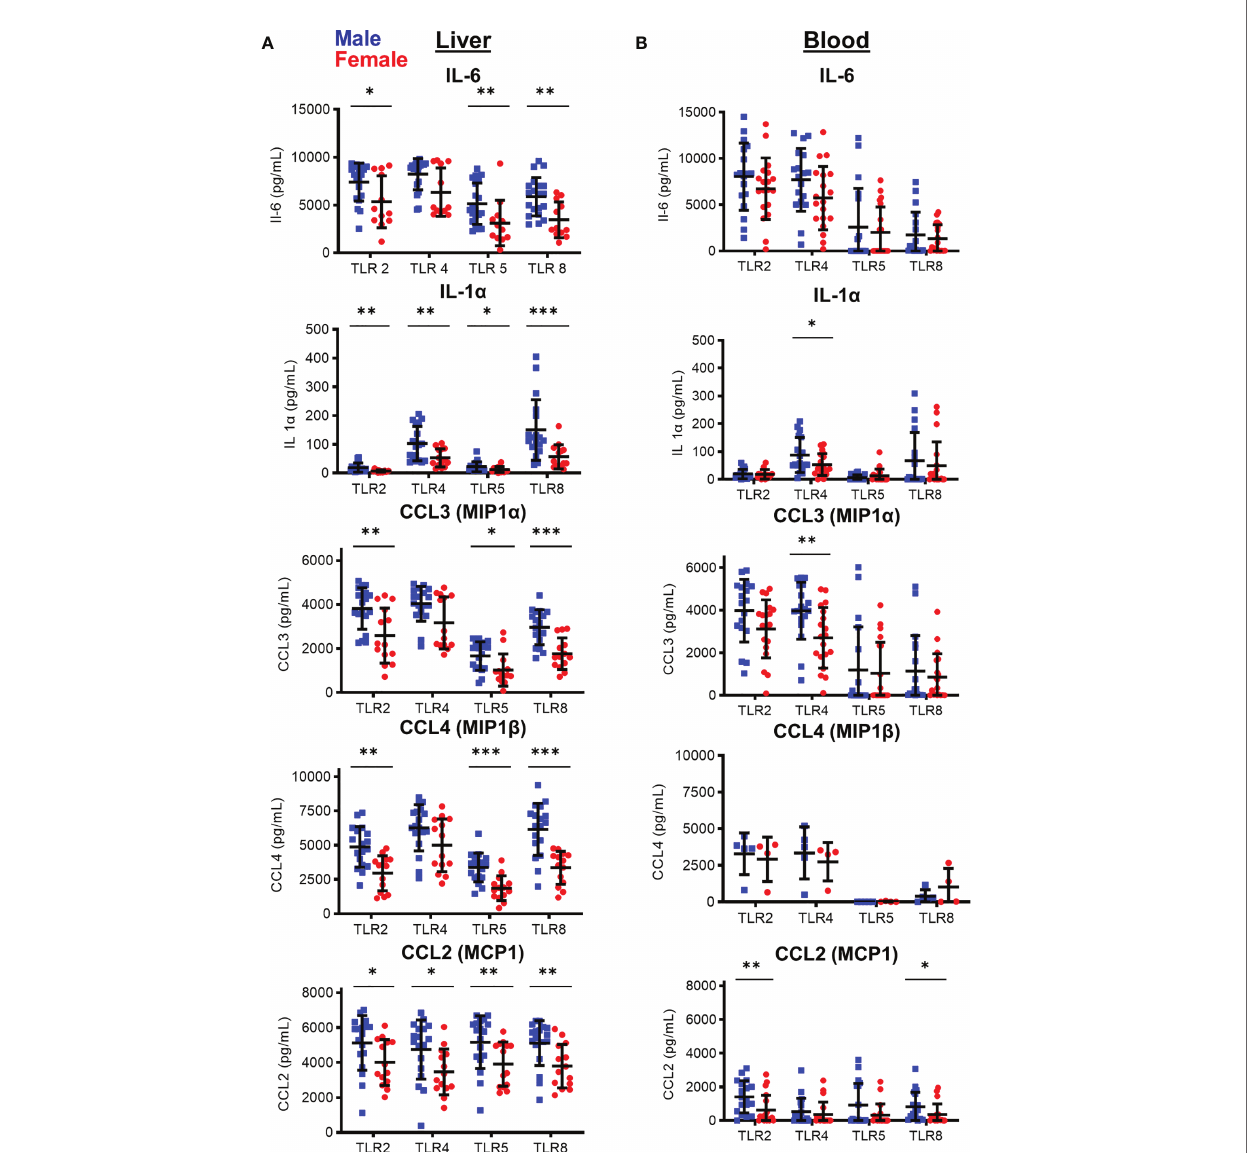
FIGURE 3 | Sex-based differences in cytokine and chemokine production by monocytes following in vitro TLR stimulation of enriched CD14 + monocytes after 24 hours. Cytokine/chemokine production by (A) Liver and (B) peripheral blood isolated CD14+ monocytes after stimulation with TLR agonists. (IHMC males, n=18; females=14; PBMC: males, n=18; females, n=19; For CCL4 PBMC males, N=5; females=4) *p < 0.05, **p < 0.01, ***p < 0.001, Mann-Whitney U tests. Figures depict mean +/-